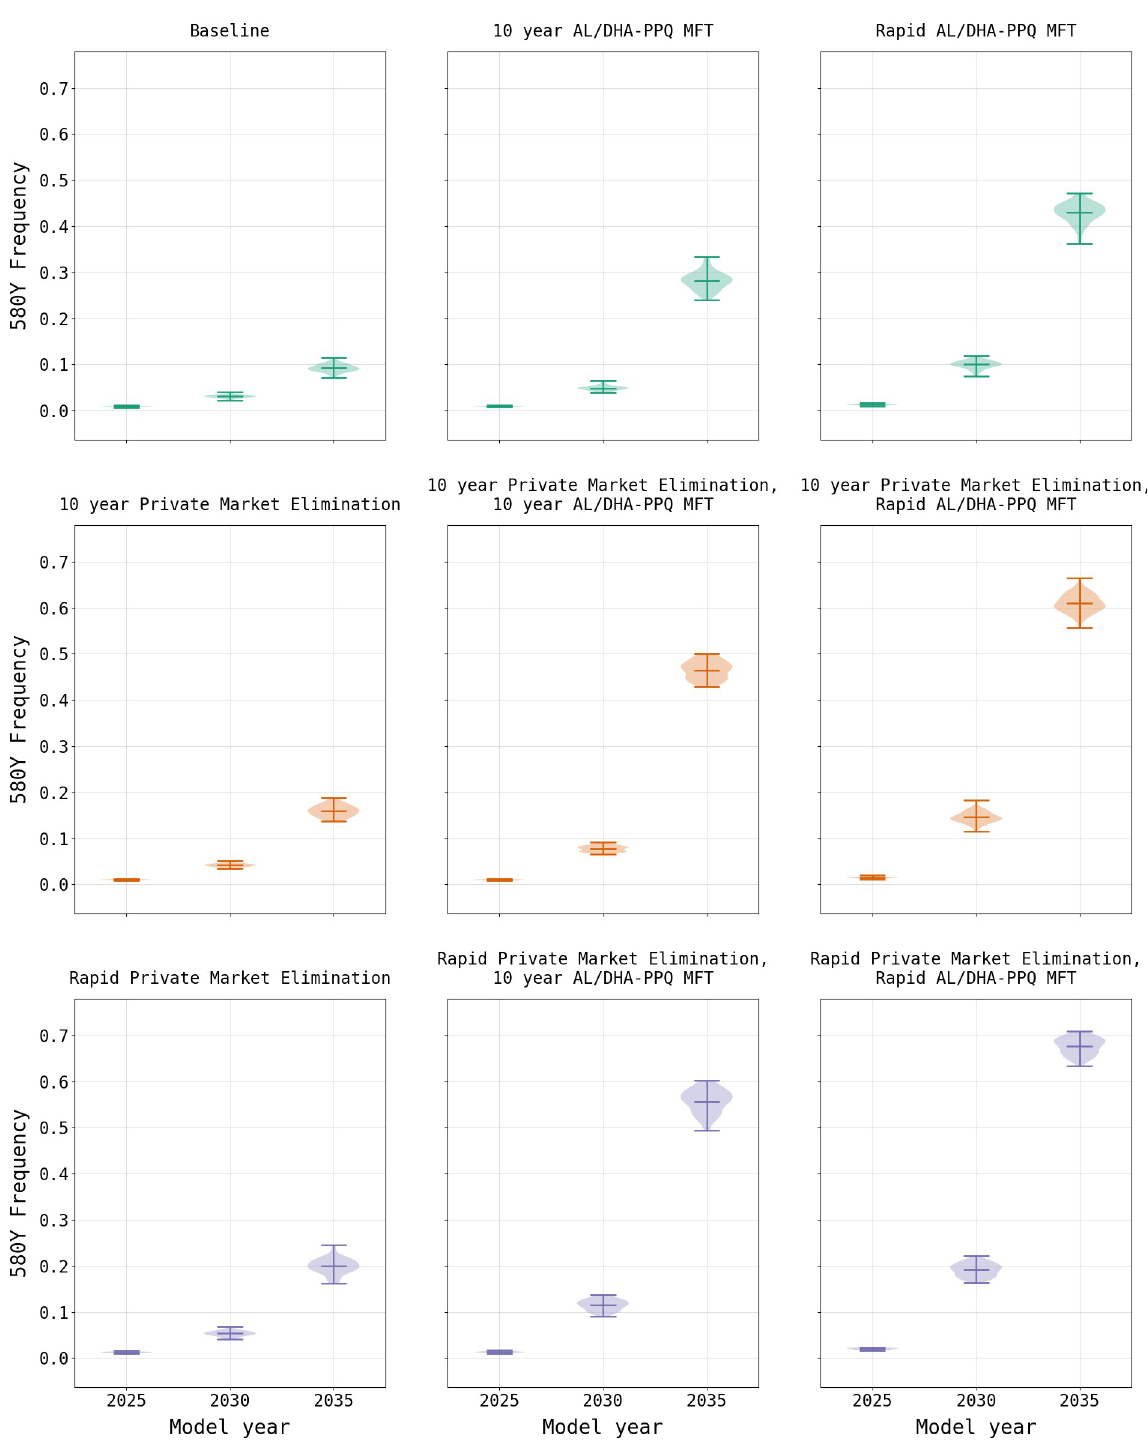
Fig 5. Comparison of 580Y allele frequency (mean and range) under two primary drug policy scenarios. AL/DHA-PPQ MFT refers to a policy of multiple first-line therapies where AL and DHA-PPQ are deployed equally in the population. Evaluations of MFT and private market elimination are shown for rapid (i.e., immediate) implementation and gradual implementation over a 10-year period. Increased use of ACTs due to private market elimination results in a small increase in the frequency of 580Y. Implementation of MFT results in higher long-term 580Y frequencies due to more rapid 580Y evolution enabled by PPQ-resistant